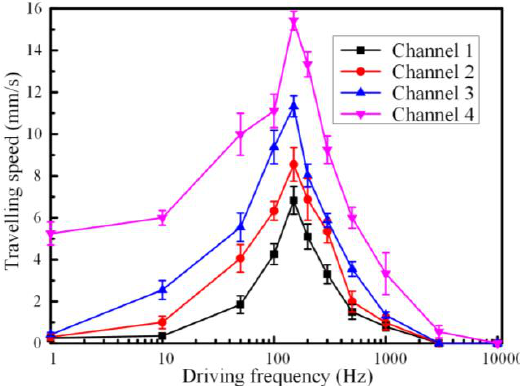
Figure 6. Plot of average actuation velocity versus different driving frequencies of the sinusoidal wave signal at 4 Vpp with 4 V DC offset when the ion concentration of NaOH was 0.4 mol/L.